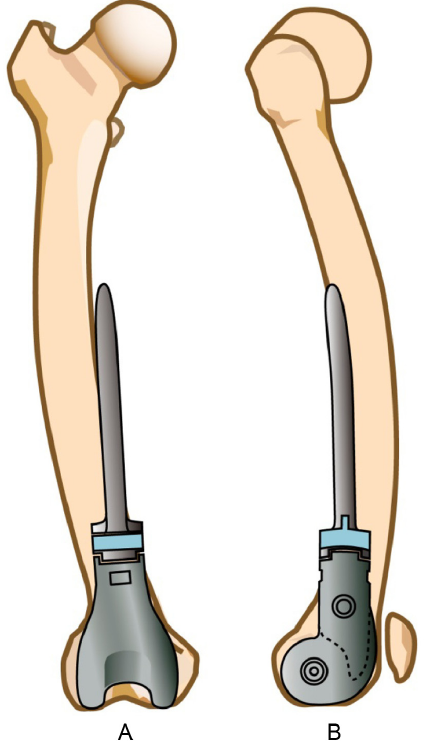
Figure 4. (A) Mismatch between the lateral femoral curve and the stem of the tumor prosthesis, which lacks a coronal plane curve, (B) mismatch between the anteroposterior femoral curve and the stem of a tumor prosthesis having sagittal plane radius of curvature of 900 mm, which is much less than the mean radius of curvature of the Japanese femur.